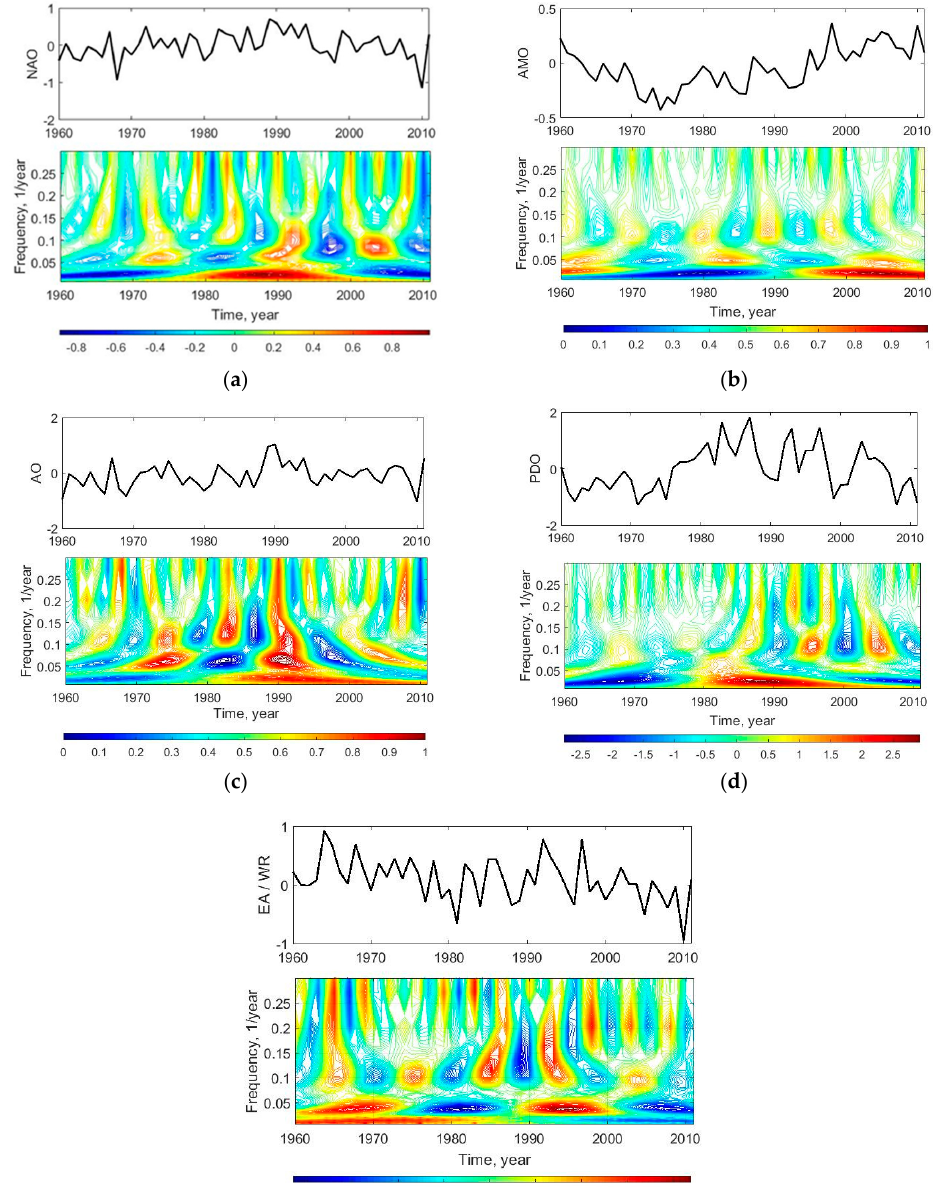
Figure 4. Wavelet transforms of NAO ( a ), AMO ( b ), AO ( c ), PDO ( d ) and EA/WR ( e ). For wavelet analysis, the mean values of the time series were deleted.